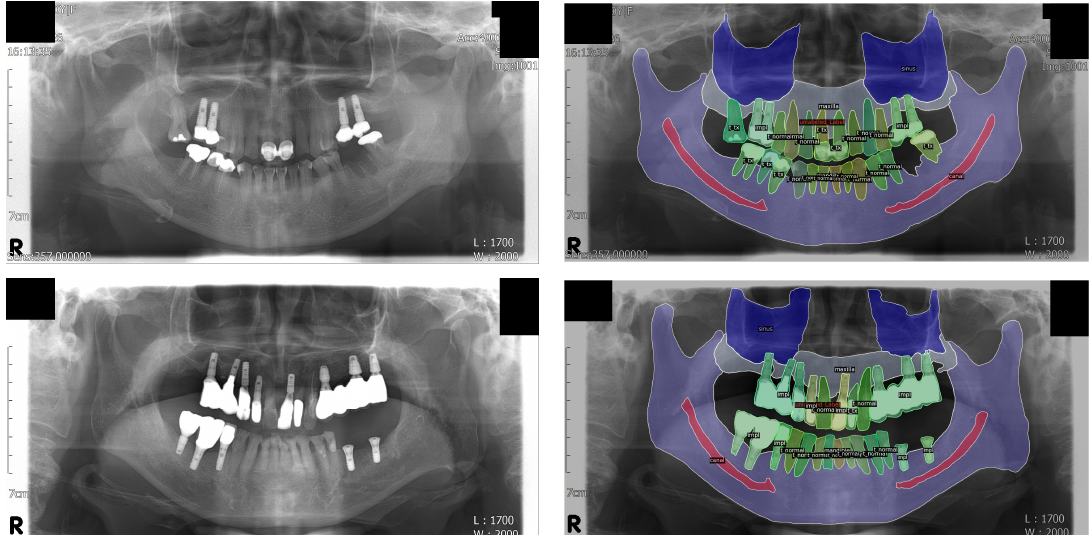
Figure 3. Visualization of the inference results. Some structures, including the mandibular canal and the medial wall of the maxillary sinus, are difficult to distinguish on the original panoramic radiographs but are fairly well segmented. Note that the normal tooth, treated tooth, and dental implant classes are individually segmented for each object; this was not possible with conventional semantic segmentation. Left: original input panoramic radiographs. Right: visualized result of the model’s inference.